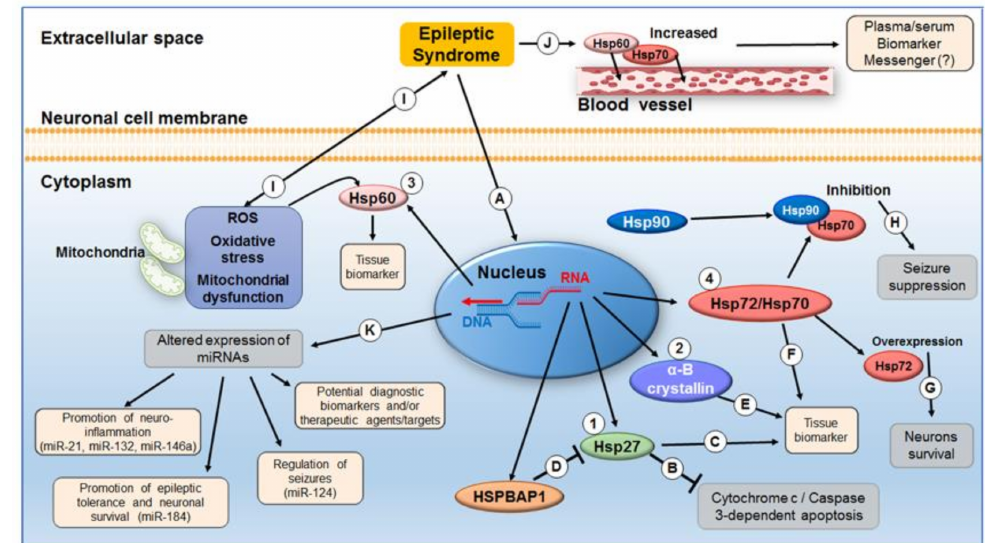
Figure 1. Molecular chaperones and miRNAs in epilepsy. The levels of Hsp27 (1), α -B crystallin (2), Hsp60 (3), and Hsp70s (4) are increased in epilepsy (A). Hsp27 could play a cytoprotective role due to its antiapoptotic activity (B) and could be a marker of the cortical tissue affected by seizures (C). The neuroprotective role of Hsp27 is also suggested by the abnormal expression of the Hsp27 inhibitor HSPBAP1 in epileptic tissue (D). In addition, the chaperone α -B crystallin is a promising tissue marker of epileptic foci (E). Likewise, Hsp72 (and other members of the Hsp70 family) increase in the epileptic status and can be considered potential markers of epileptic tissue foci (F). Hsp72 overexpression plays a cytoprotective role by promoting neuronal survival during seizures (G) [47] but overexpression following epileptic stress is accompanied by increased neuronal hyperactivity; thus, pharmacological inhibition of the chaperone suppresses neuronal hyper excitability (H) [48]. A similar seizure-suppression effect was observed following Hsp90- β inhibition (H). Mitochondrial dysfunction, free radical production, and oxidative stress are considered both cause, and consequence of epileptic seizures (I). Mitochondrial Hsp60 increases in response to the oxidative stress induced by epileptic seizures, pointing to its potential as epileptic tissue biomarker [49]. The levels of Hsp70 and Hsp60 increase in plasma and/or serum of epileptic patients following seizures; thus, assessing the levels of these chaperones is a promising way to retrospectively diagnose seizures and may help in patient follow up. sequential measurements after a seizure may reveal profiles useful for predicting a new seizure (J). Altered expression of different miRNAs has an impact on various cellular processes pertinent to epilepsy (K). For instance, miR-21 and miR-132 [39] and miR- 146a [35,36] are upregulated following epileptic status both in animal models and MTLE patients showing neuroinflammation; miR-184 is upregulated in KA-treated mice and positively correlates with the development of epileptic tolerance and with neuronal survival following mild and severe seizures [38]; miR-124 is downregulated in patients with epilepsy and rats after drug-induced seizures and, when it is augmented, it suppresses seizures by inhibiting the expression of CREB, a key regulator in epileptogenesis